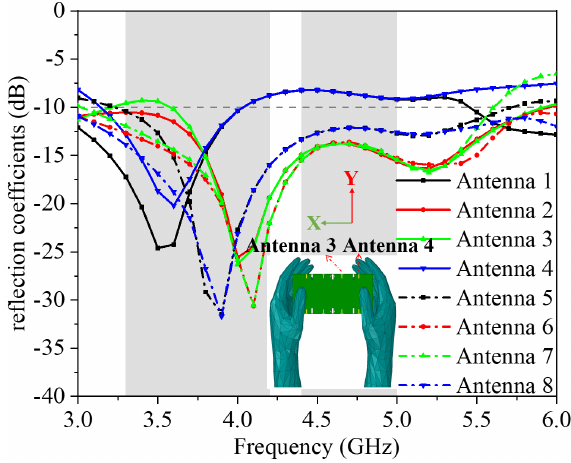
Figure 6. The simulation results of the reflection coefficients of the presented antenna in DHM.